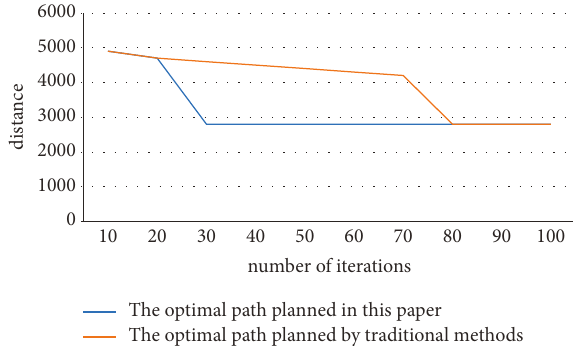
Figure 5: The path change diagram of the two methods.